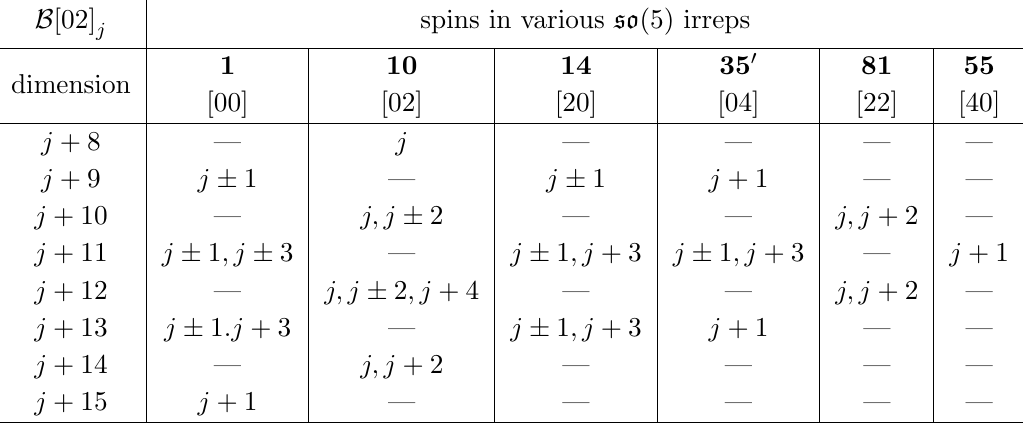
Table 6 . All possible conformal primaries in D [20] (cid:2) D [20] corresponding to the B [02] formal multiplet.